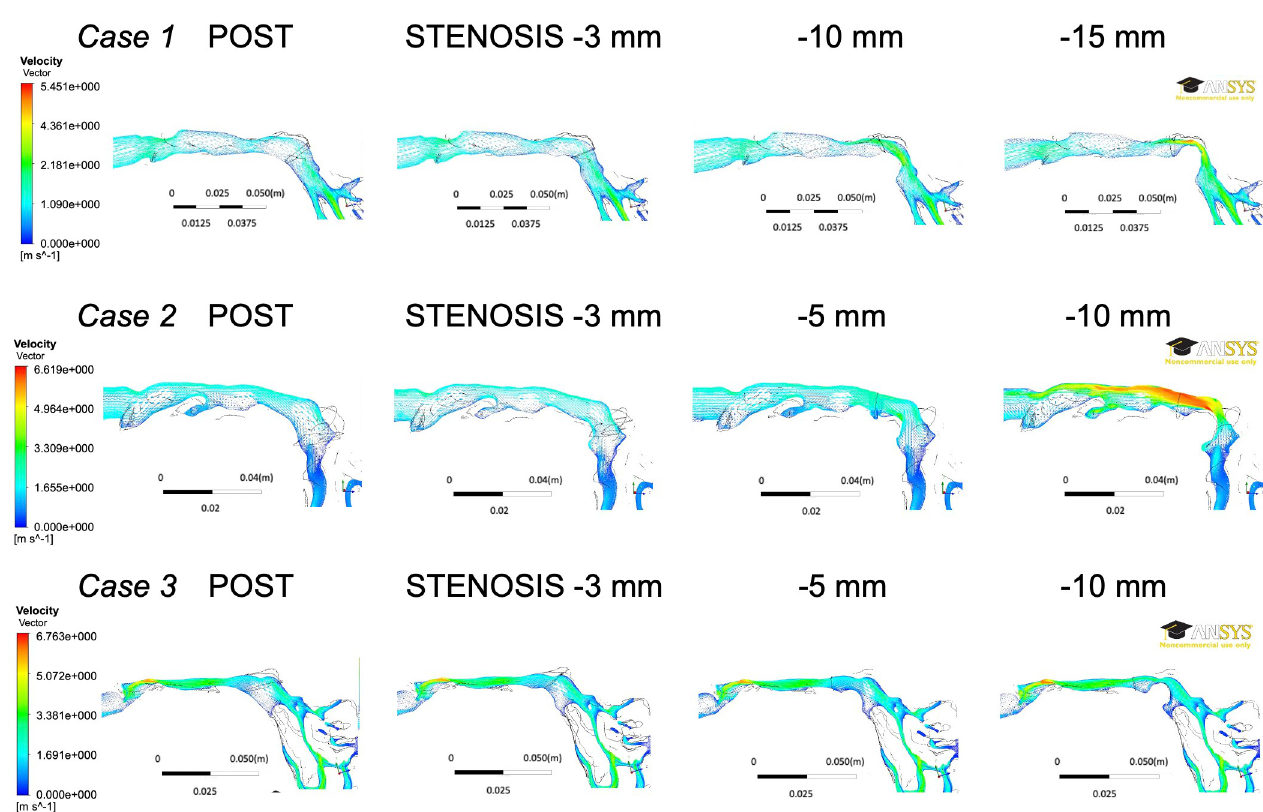
Fig 11. Flow fields of the sagittal section of the nasopharynx for each model. The direction of flow is from the lower right (nasal cavity side) to the left (oropharyngeal side).